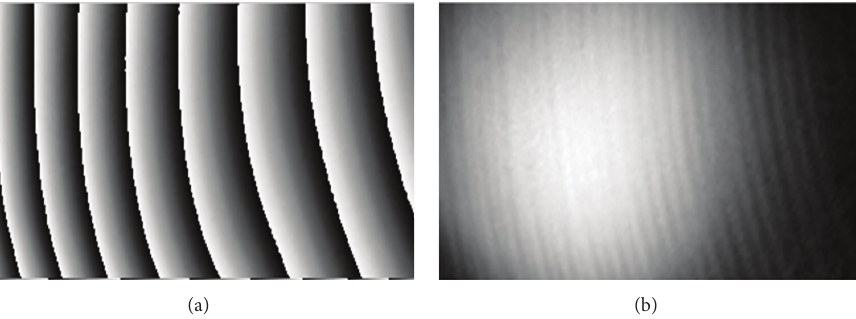
Figure 27: Wrapped and unwrapped phase map corresponding to the selected area of interest.